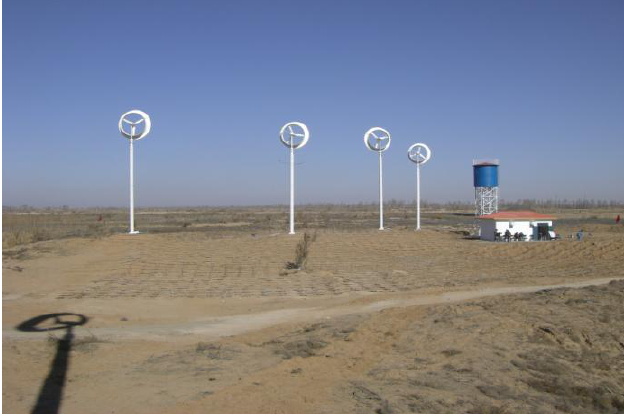
Figure 16 . An irrigation-greenery plant using wind energy (5 kW wind-lens turbine farm) in a desert area in northwest